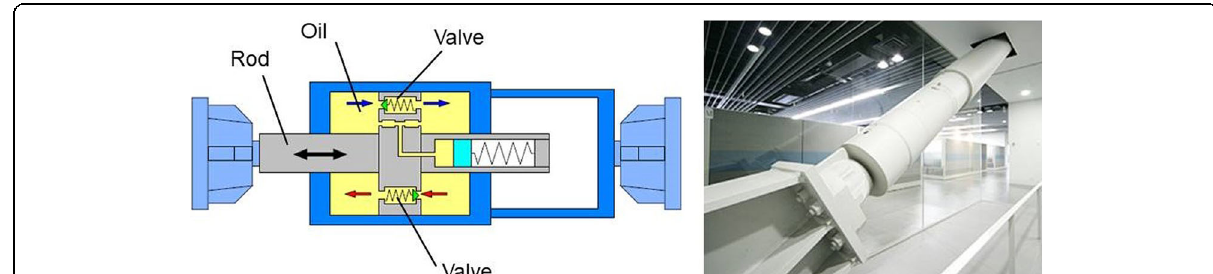
Fig. 18 Viscous fluid damper